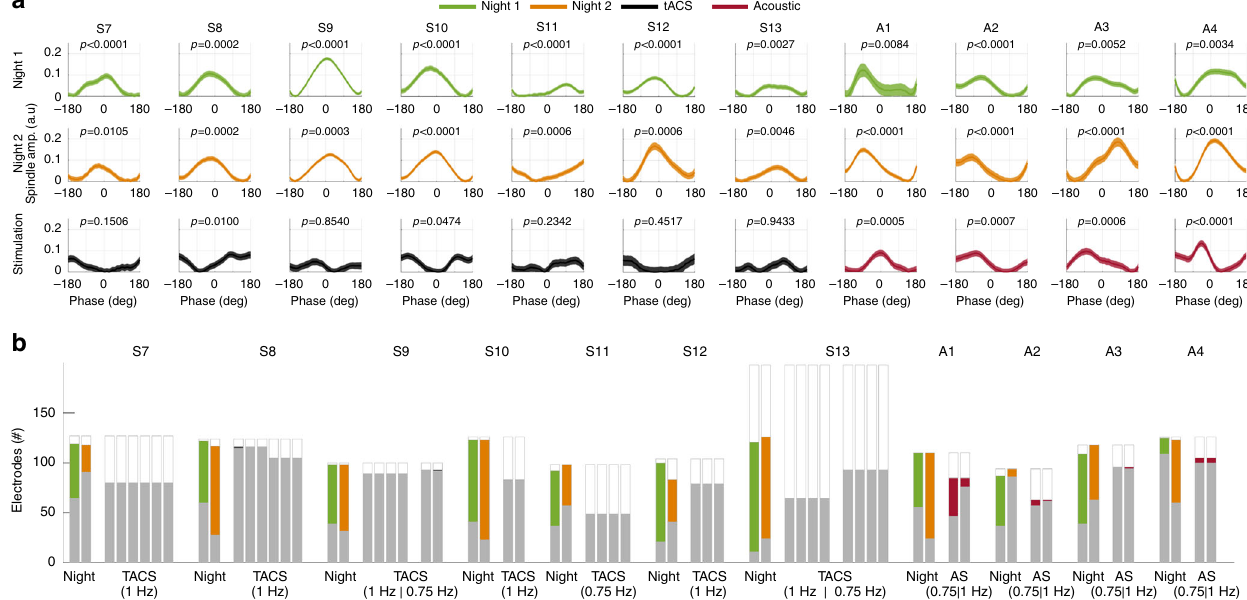
Fig. 4 Modulation of fast spindle power with phase of the slow oscillation. Different conditions are indicated in color: endogenous sleep (green, orange), tACS (black), acoustic stimulation (AS, red). a Fast spindle power (14 Hz band) relative to the phase of slow oscillation shown in one representative electrode for each subject. Here, 0° phase corresponds to the physiological upstate of slow-wave activity. For endogenous slow-wave oscillation sleep periods (green and orange) phase is determined from 1 Hz bandpassed signal. For tACS (black traces) and acoustic stimulation (AS, red traces) blocks during nap (S7 – S10, A2 – A3) and during night-time sleep (S11 – S13, A1, A4), phase is determined from the stimulation artifact or acoustic trigger pulses in the recordings, where 0° corresponds to the peak in anodal stimulation (e.g., peak positive stimulation relative to frontal/anodal electrode) for tACS, or the time of sound delivery in the case of AS. Note the modulation of spindle power with the phase of the endogenous slow oscillation in each subject during night-time sleep and during acoustic stimulation, and the lack of consistent modulation with the phase of tACS. Both nights have similar preferred phase. Each column represents the same electrode per subject. b Fraction of recordings sites with signi fi cantly entrained spindle activity during endogenous sleep, tACS, and acoustic stimulation. Each bar represents a block of data analyzed. Bar height indicates the number of electrodes available, with a fraction of electrodes discarded due to poor data quality or excessive interictal activity (white), a fraction of electrodes with non-signi fi cant entrainment (gray), and a fraction of electrodes with signi fi cant spindle entrainment (night 1, green; night 2, orange; tACS, black; AS, red) after correction for multiple comparisons. Each bar during tACS/AS represents a stimulation block of 5 min. During tACS stimulation only two recording sites (in S8, fi rst block, red bar; and S09, second block of 0.75 Hz, red bar) showed signi fi cant spindle entrainment, although this was not a stable fi nding across stimulation blocks. With acoustic stimulation, many more electrodes were found to be reliably entrained across both 0.75 and 1 Hz stimulation